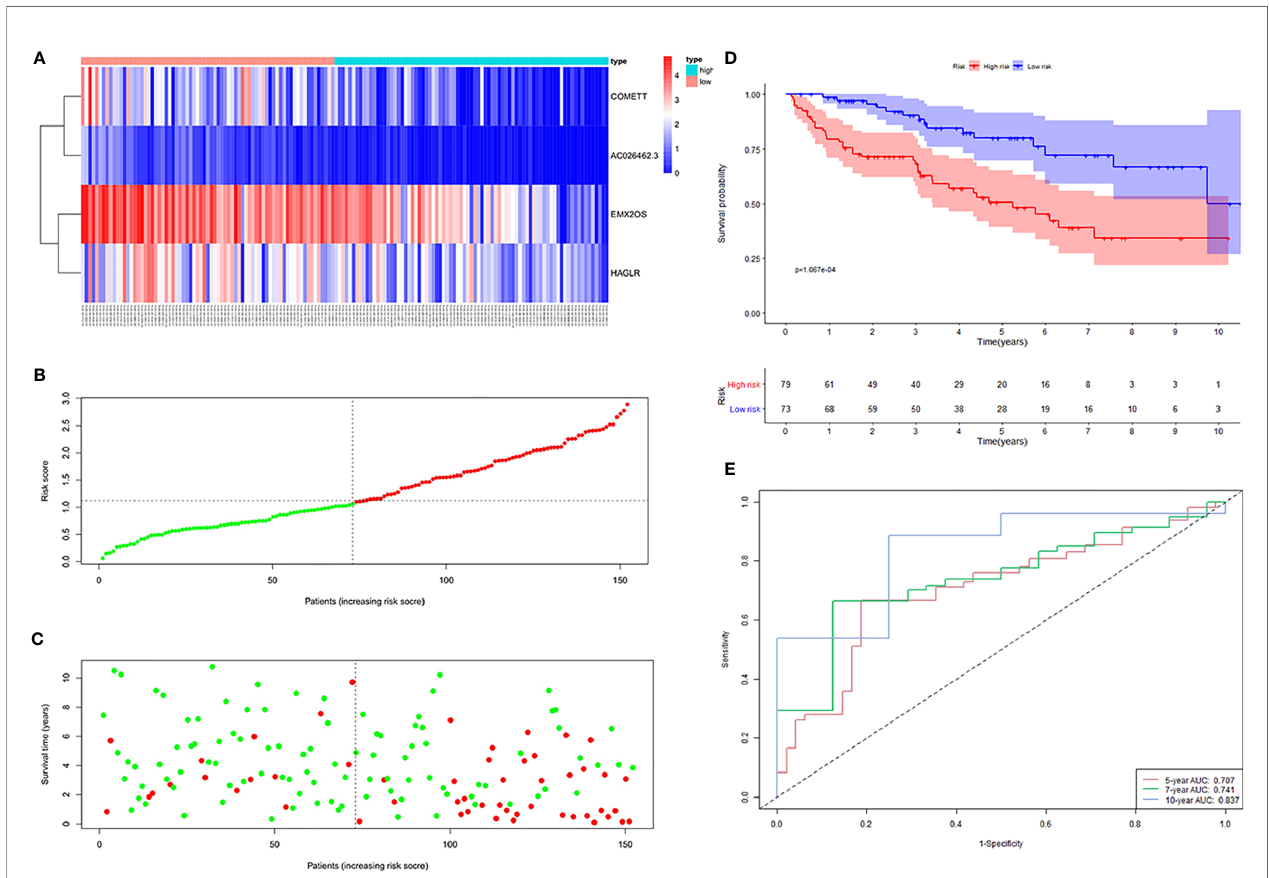
FIGURE 4 | Four hypoxia-related lncRNA signature validated in the testing cohort (n = 152). (A) Expression values of the four signature lncRNAs. The colors from red to blue correspond to the expression of a lncRNA from high to low. The risk score (B) and survival status (C) of each ccRCC patient distributed in low- and high- risk groups. (D) KM survival analysis between the high-risk group and low-risk group. The lower layer demonstrates the number of alive ccRCC patients in each group. (E) Time-dependent ROC curves of the